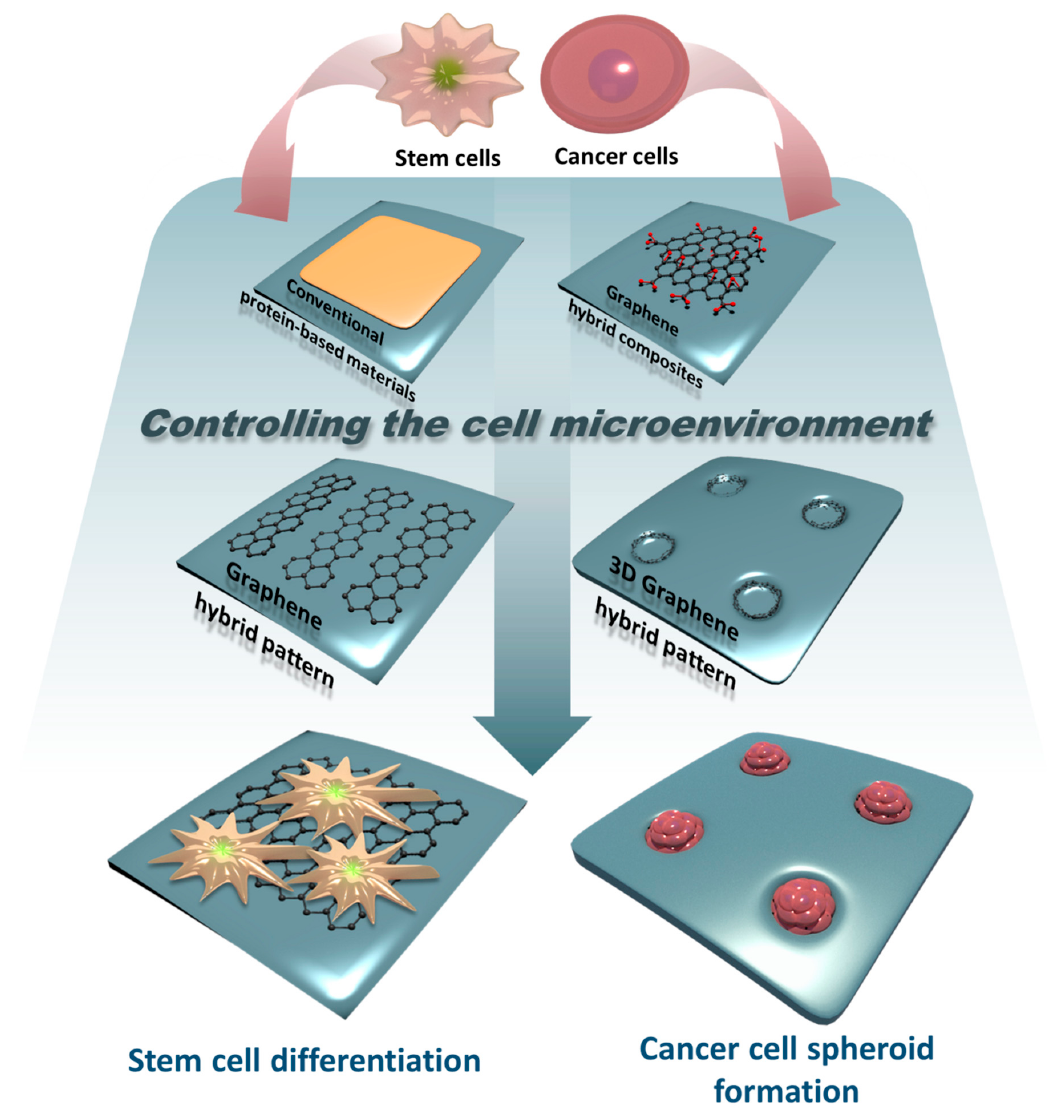
Figure 1. Schematic diagram related to controlling stem cell or cancer cell microenvironments using protein-based materials, graphene hybrid composites, graphene hybrid patterns, and 3D graphene hybrid patterns.